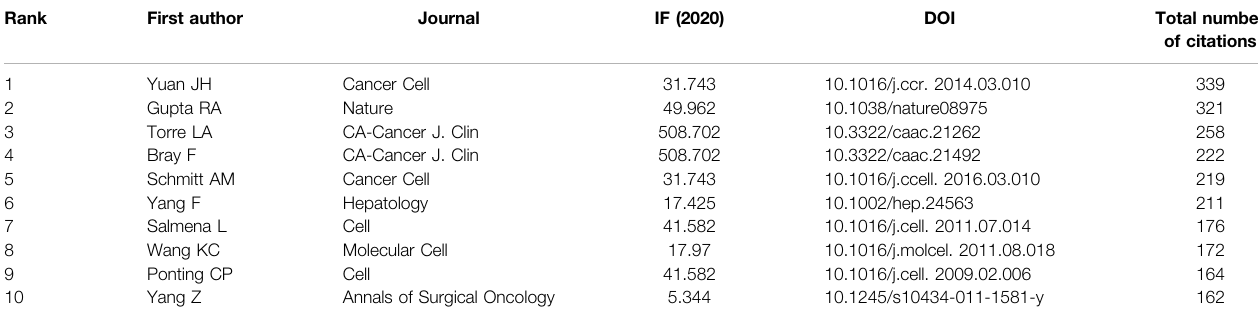
TABLE 5 | Highly frequent cited papers on the roles of lncRNAs in HCC